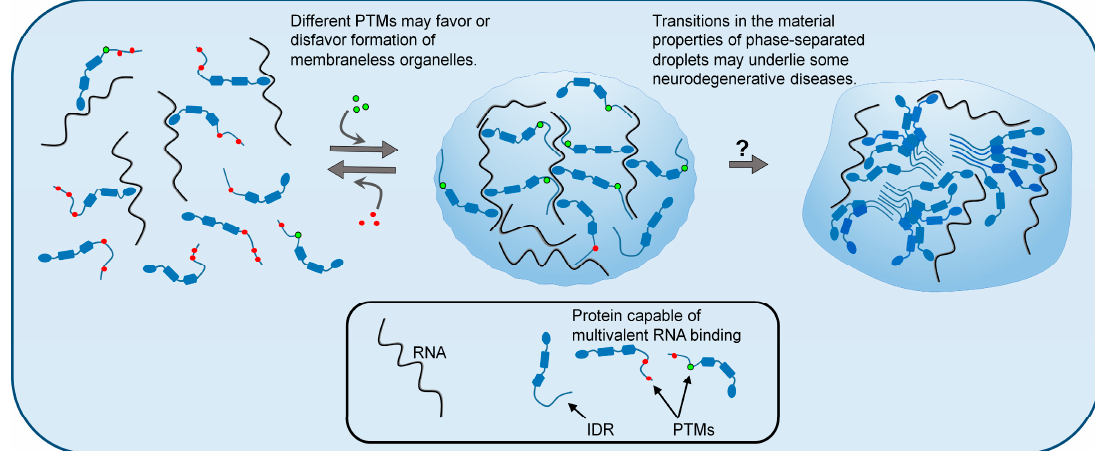
Figure 1. Liquid–liquid phase separation (LLPS) of biopolymers, such as proteins and RNA, is a mechanism by which cells organize their contents into specific functional structures called membraneless organelles (MLOs). Post-translational modifications (PTMs) of intrinsically disordered proteins can influence LLPS and thus regulate the formation and dissolution of MLOs. The figure depicts different patterns of PTMs favoring dispersed or condensed states. Changes in the material properties of liquid-phase separated granules are hypothesized to cause some neurodegenerative diseases. According to this hypothesis, droplets lose their liquid (reversible) properties and adopt more rigid (less reversible) internal structures, which may be glass-like, or in some cases, may have solid amyloid-like structures. These irreversible phase states may have gain-of-function toxicity to neurons.